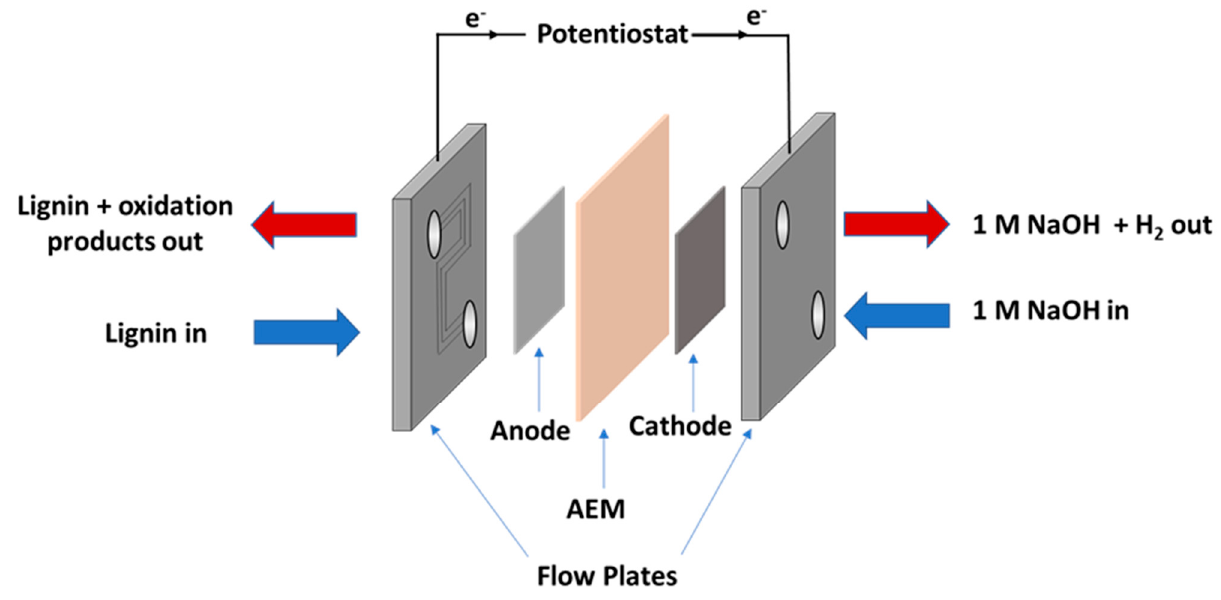
Figure 1. Diagram of the electrolyser cell setup used for lignin electrolysis. The electrolyser setup is a “zero-gap” configuration where the anode and cathode catalysts are sandwiched between the conductive flow plates. The potentiostat is connected to each flow plate by way of terminal spades with banana jacks, and so the flow plates also function as current collectors.